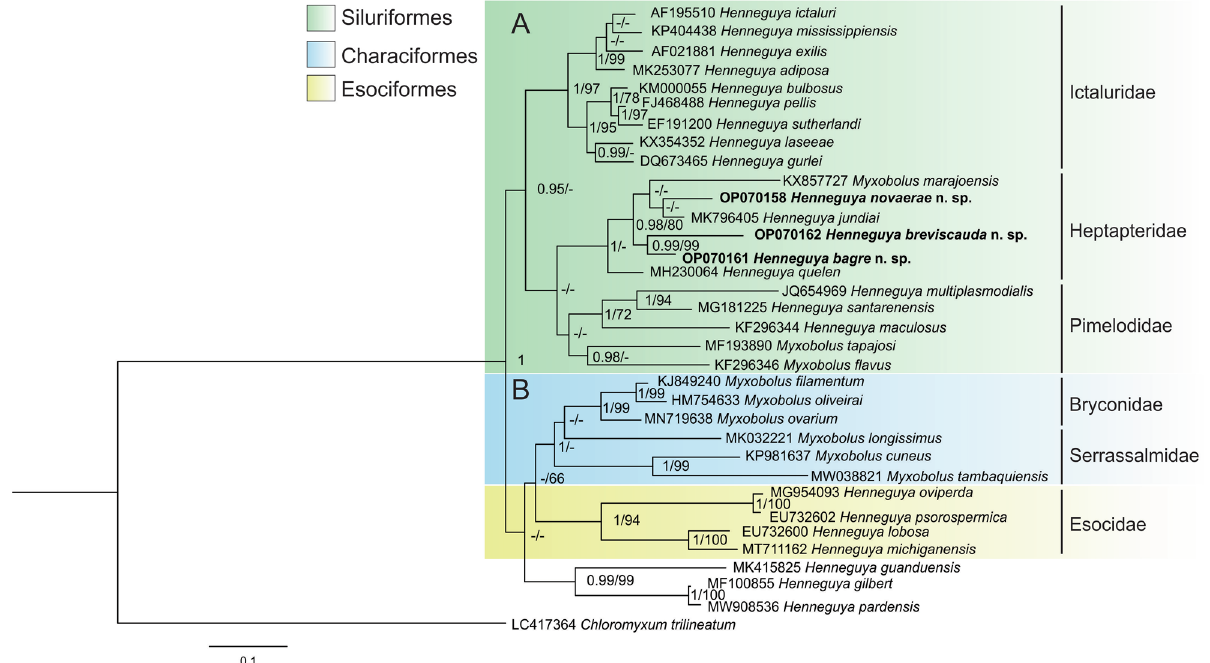
Figure 5. Phylogenetic tree of Bayesian analysis based on partial ssrDNA sequences showing the position of the new species among other genetically similar Myxobolus / Henneguya species. Node numbers represent the Bayesian posterior probabilities (BI) and bootstrap. Values less than 0.95/65 are represented by dashes. The scale bar represents the number of substitutions per